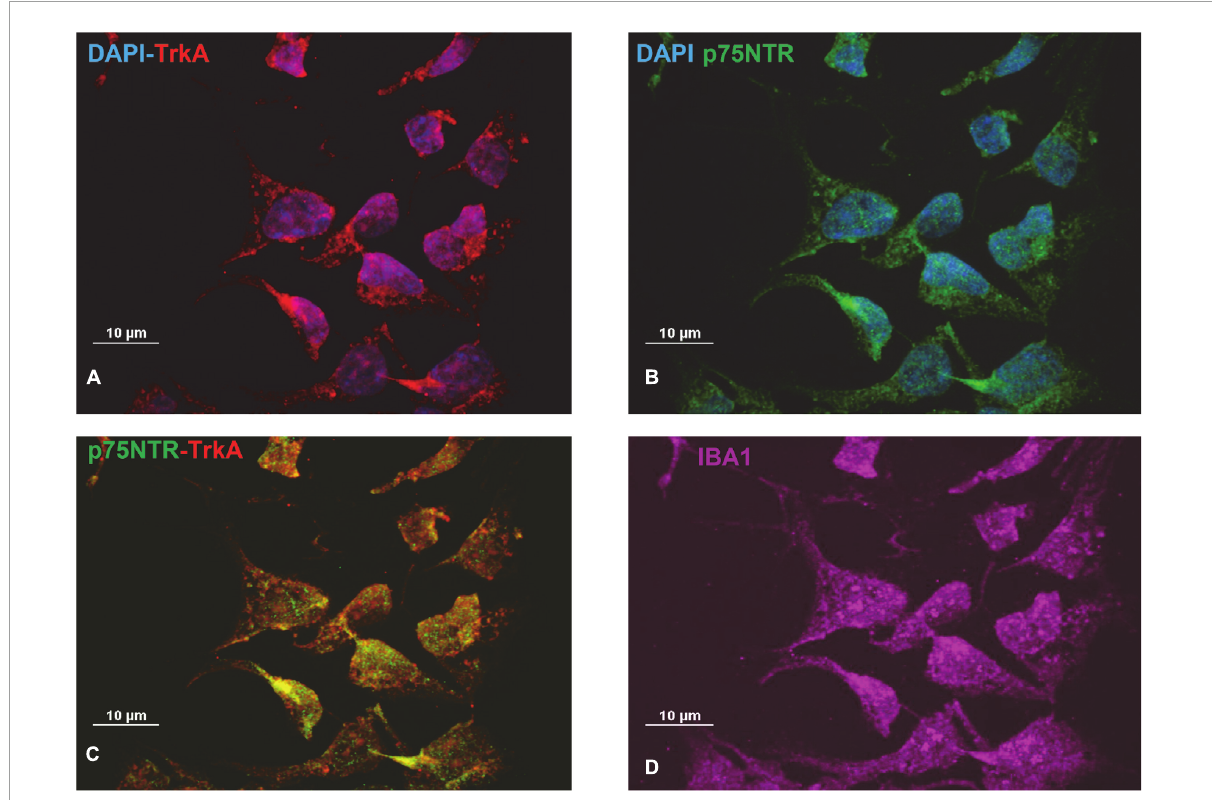
FIGURE2 Expression of nerve growth factor (NGF) receptors in Imhu cell lines. (A) Tropomyosin receptor kinase A (TrkA) positive cells. (B) p75 neurotrophin receptor (P75NTR) positive cells. (C) Co-localization of P75TNTR and TrkA on Imhu. (D) IBA positive cells. Magnitude 60X; scale bar 10 µ